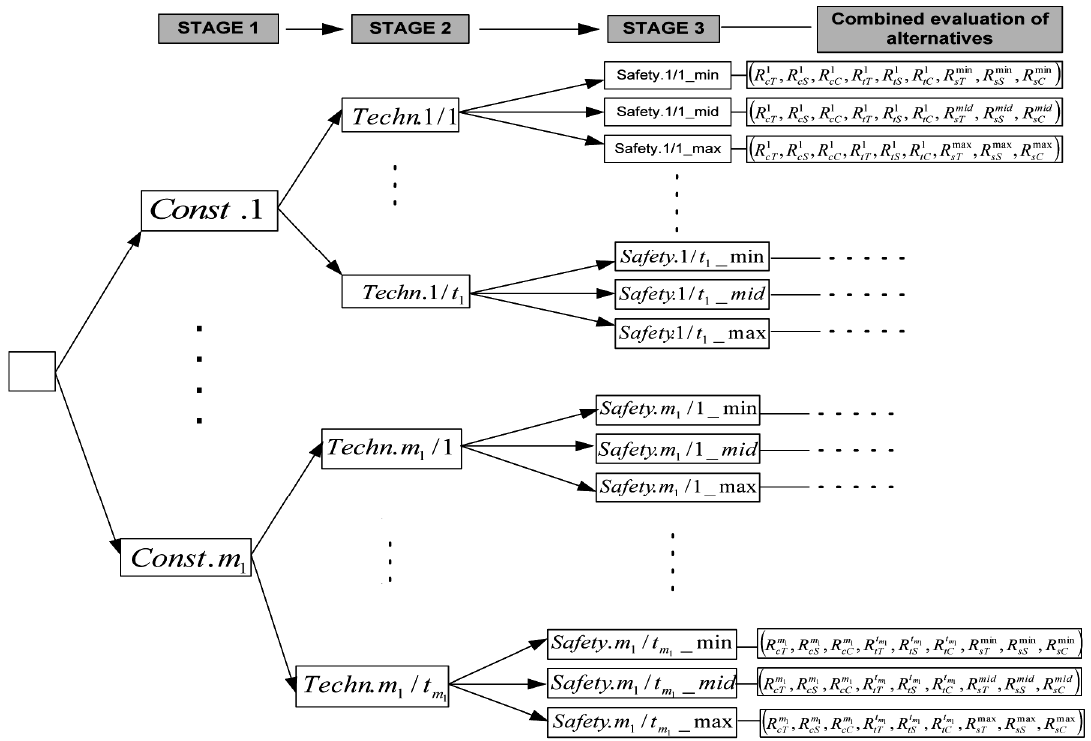
Fig. 3. The synthesis model of multiple attribute